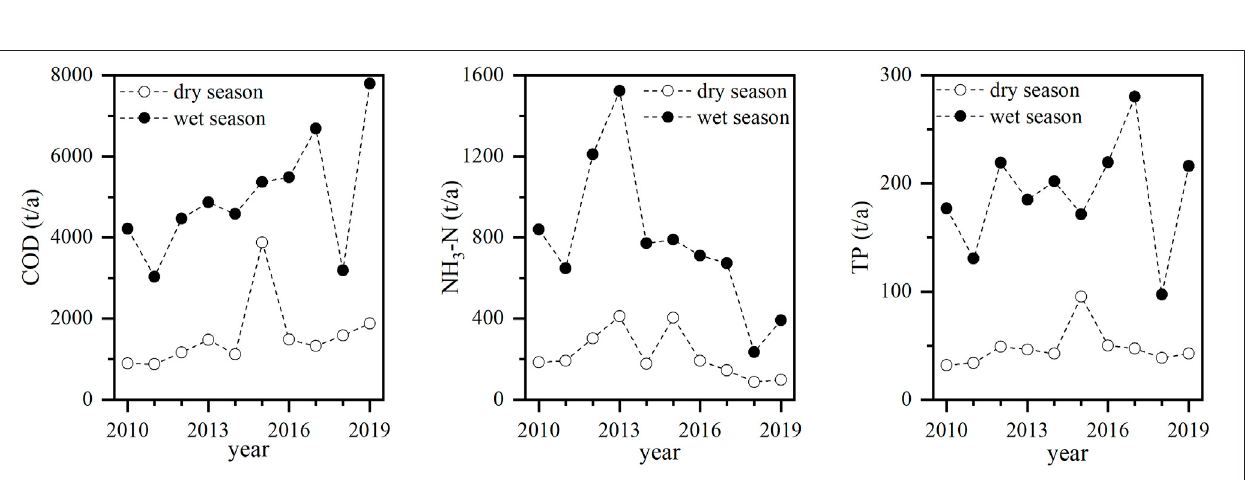
FIGURE 4 | Estimated seasonal fl uxes of COD, NH 3 -N, and TP from 2010 to 2019.